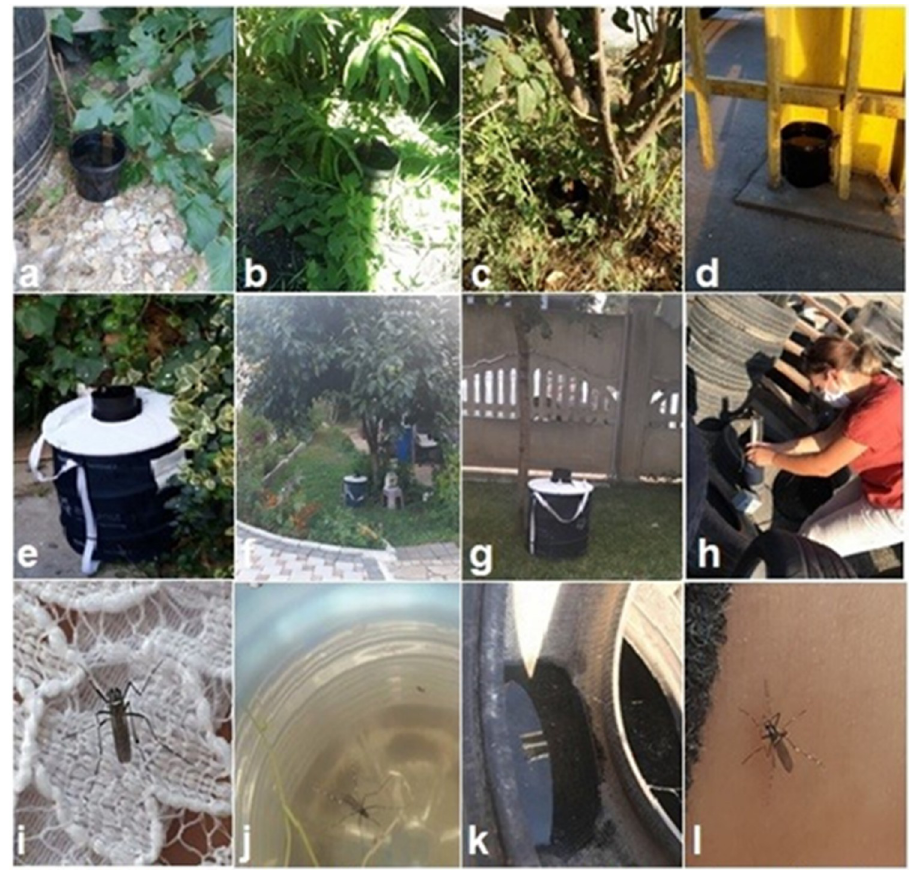
Fig 1. Examples of traps operating at several mosquito collection sites. Ovitraps in: a Vlashnje (Tyrecentres); b Zhur st.1 (Privat residence garden); c Prizren (Privat residence garden); d Ve¨rmice¨ (Restaurant veranda); e Odour-baited adult traps (BG-Sentinel) Vermice (Restaurant garden); f Zhur st.1 (Resident garden); g Prizren (Resident garden). Catching with aspirator: h Vlashnje (Tyrecentres). Adults resting in: i Prizren (on the human body); j Zhur (Plastic bottle); k Vlashnje (Inside the tire, resting on the surface water); l Zhur st.1 (first specimen of Aedes albopictus caught while landing on human